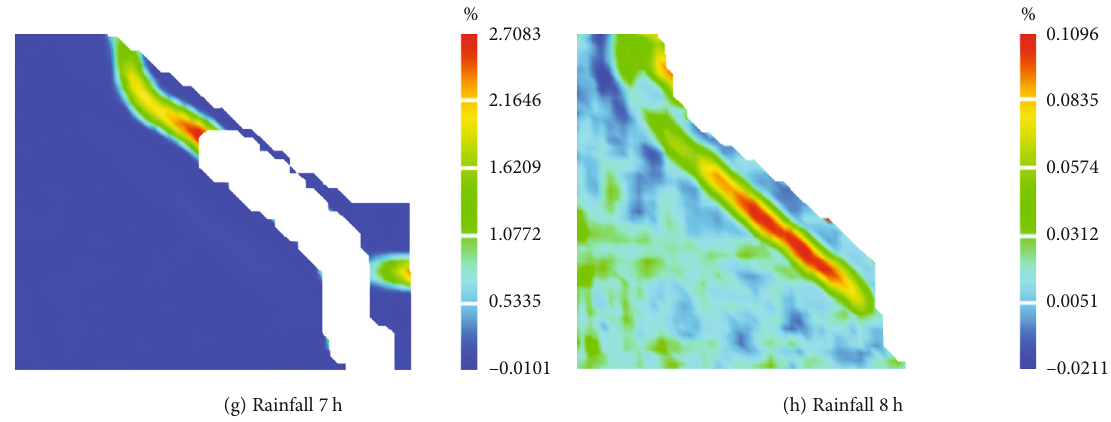
Figure 24: Slope strain changes under extreme rainfall